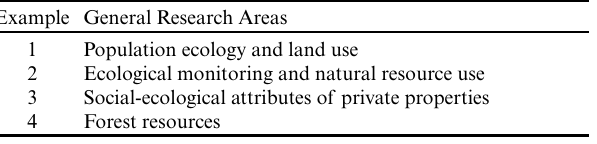
Table 2 . Descriptions of social-ecological research projects conducted by graduate students in the Long-Term Ecological Research